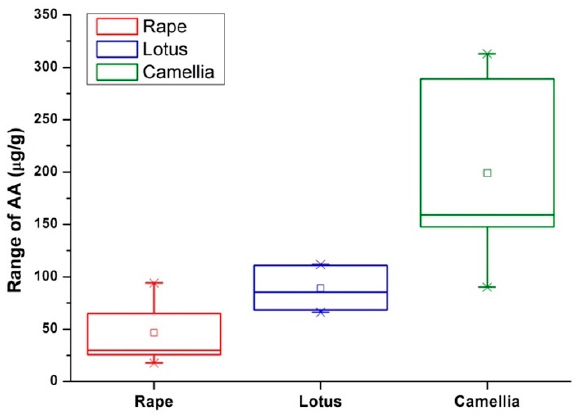
Figure 4. Distribution of the contents of AA in the investigated bee pollen samples.